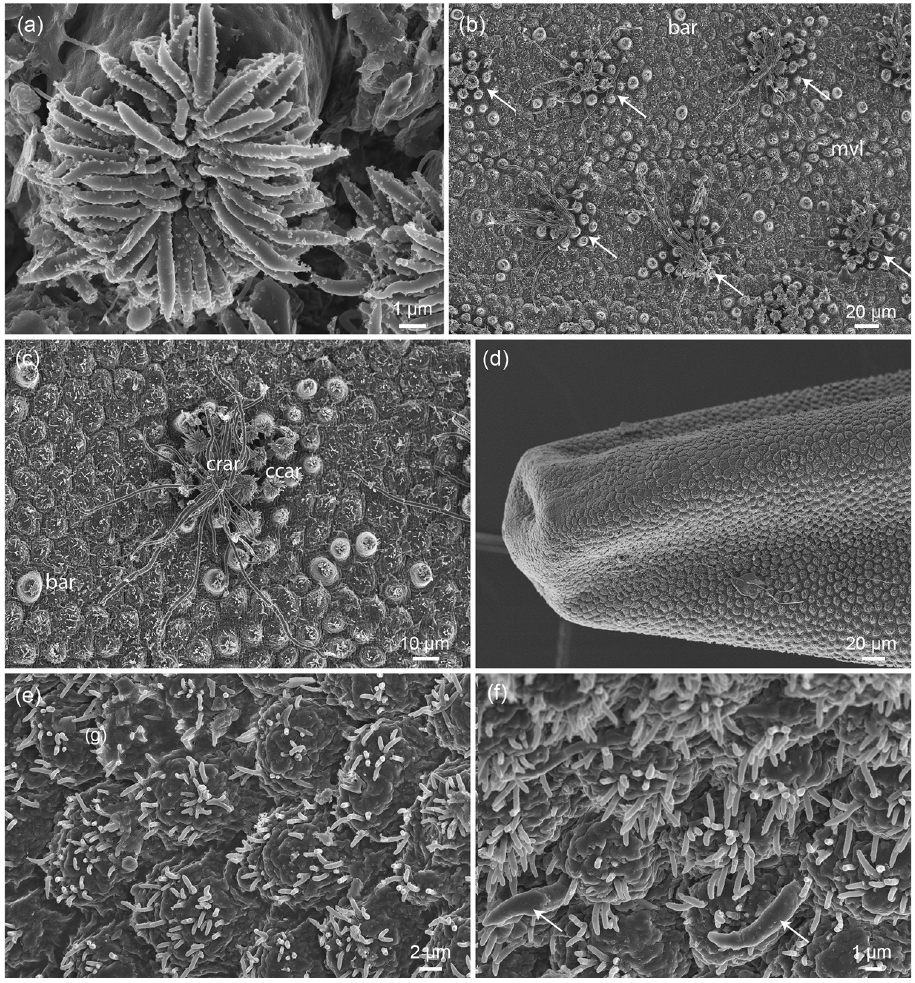
Figure 4. Chordodes cf. furnessi : a fine structure of areole from a crowned areole cluster b clusters con- taining crowned areoles with long apical bristles (arrowed) along the assumed midventral line ( mvl ) c in such clusters crowned areoles ( crar ) and circumcluster areoles ( ccar ) can be distinguished (bar = bulging areoles) d anterior end of the animal e fine structure of areoles in the anterior end f some spines (arrowed) are present between the areoles in the anterior